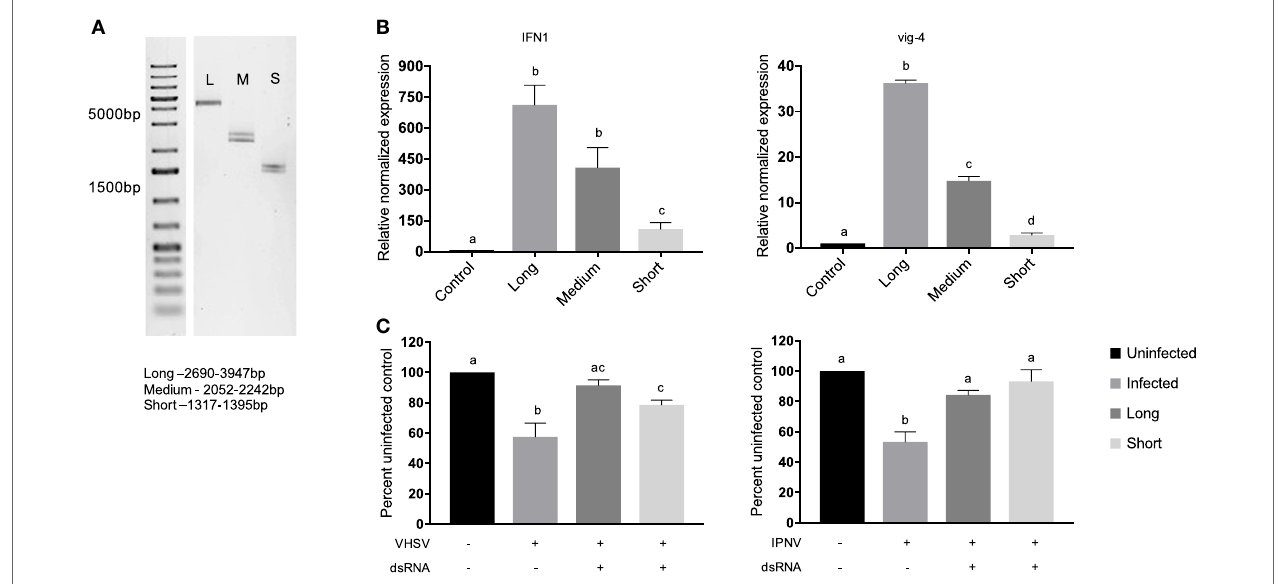
FigUre 3 | Long v-dsRNA segments induces higher levels of IFN1 and vig-4 transcripts but similar antiviral responses against viral hemorrhagic septicemia virus (VHSV) or infectious pancreatic necrosis virus (IPNV) in RTG-2 cells. Segments of the chum salmon reovirus genome were isolated based on length, segments fell into long (2,690–3,947 bp), medium (2,052–2,242 bp), or short (1,317–1,395 bp) segment groups. (a) 20 ng of the isolated segments was run on a 1% agarose gel stained with ethidium bromide for visualization. (b) RTG-2 cells were treated with 0.05 nM dsRNA for 3 h, and IFN1 and vig-4 transcripts were measured by qRT-PCR, normalized to β -actin, and presented as values relative to an unstimulated control. (c) RTG-2 cells were pretreated with 0.05 nM dsRNA for 3 h and then infected with VHSV at a multiplicity of infection (MOI) of 10 or IPNV at an MOI of 0.2. After 4–7 days a fluorescent indicator dye, alamarBlue, was used to measure cell viability, and data are presented as the percentage of an untreated, uninfected control. Data represent at least three independent replicates and were analyzed statistically by one-way ANOVA, alpha = 0.05; a P value < 0.05 considered